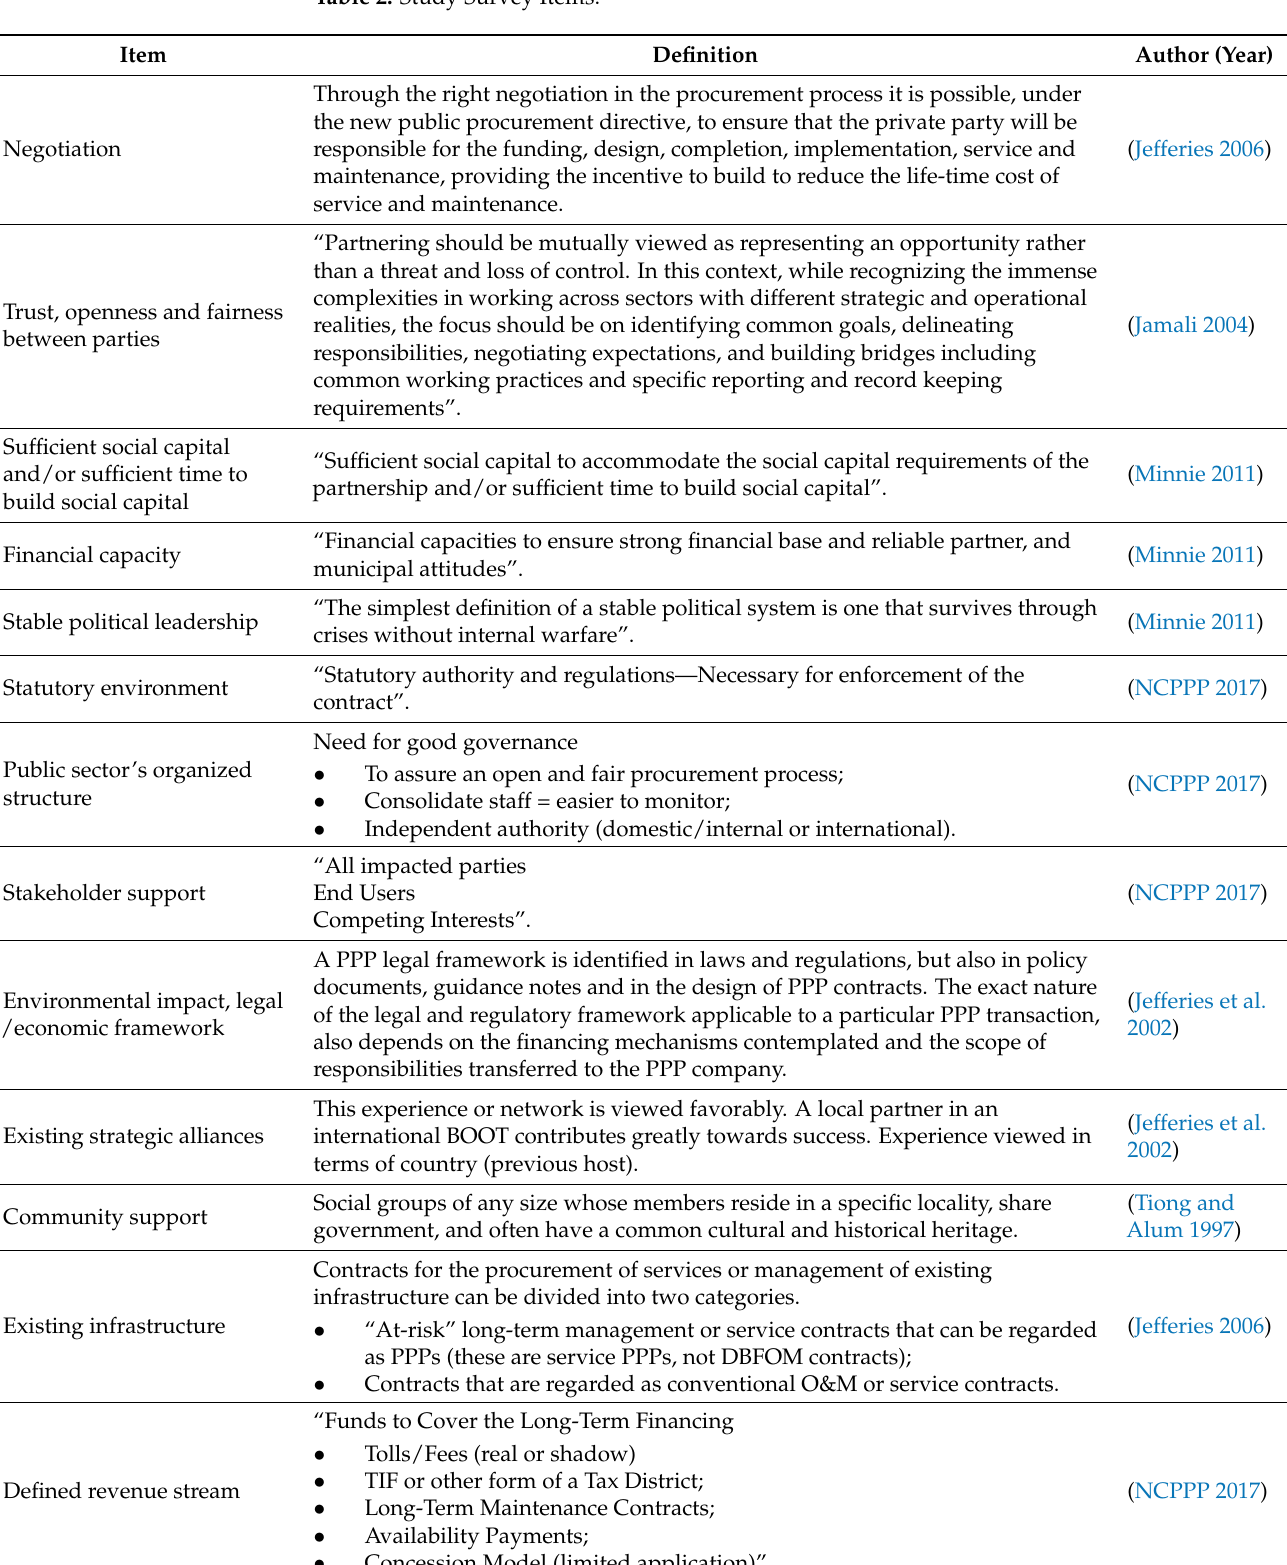
Table 2. Study Survey